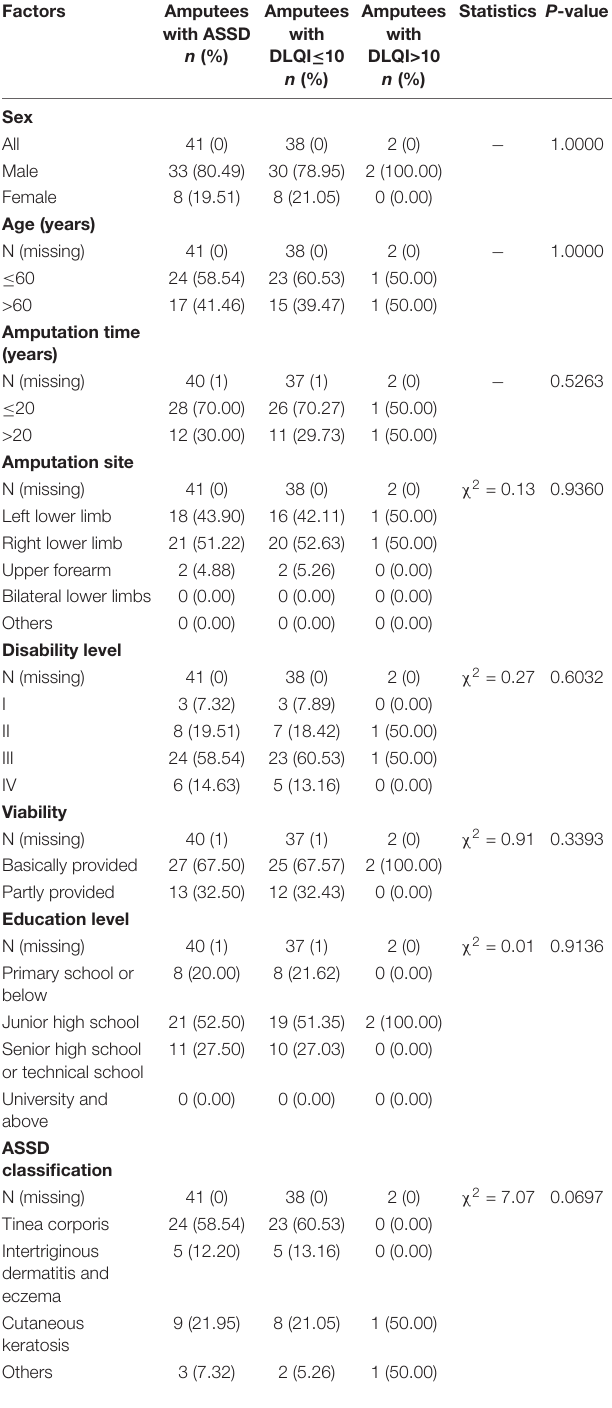
TABLE 3 | Distribution of participants with ASSD via the DLQI score according to sociodemographic and clinical